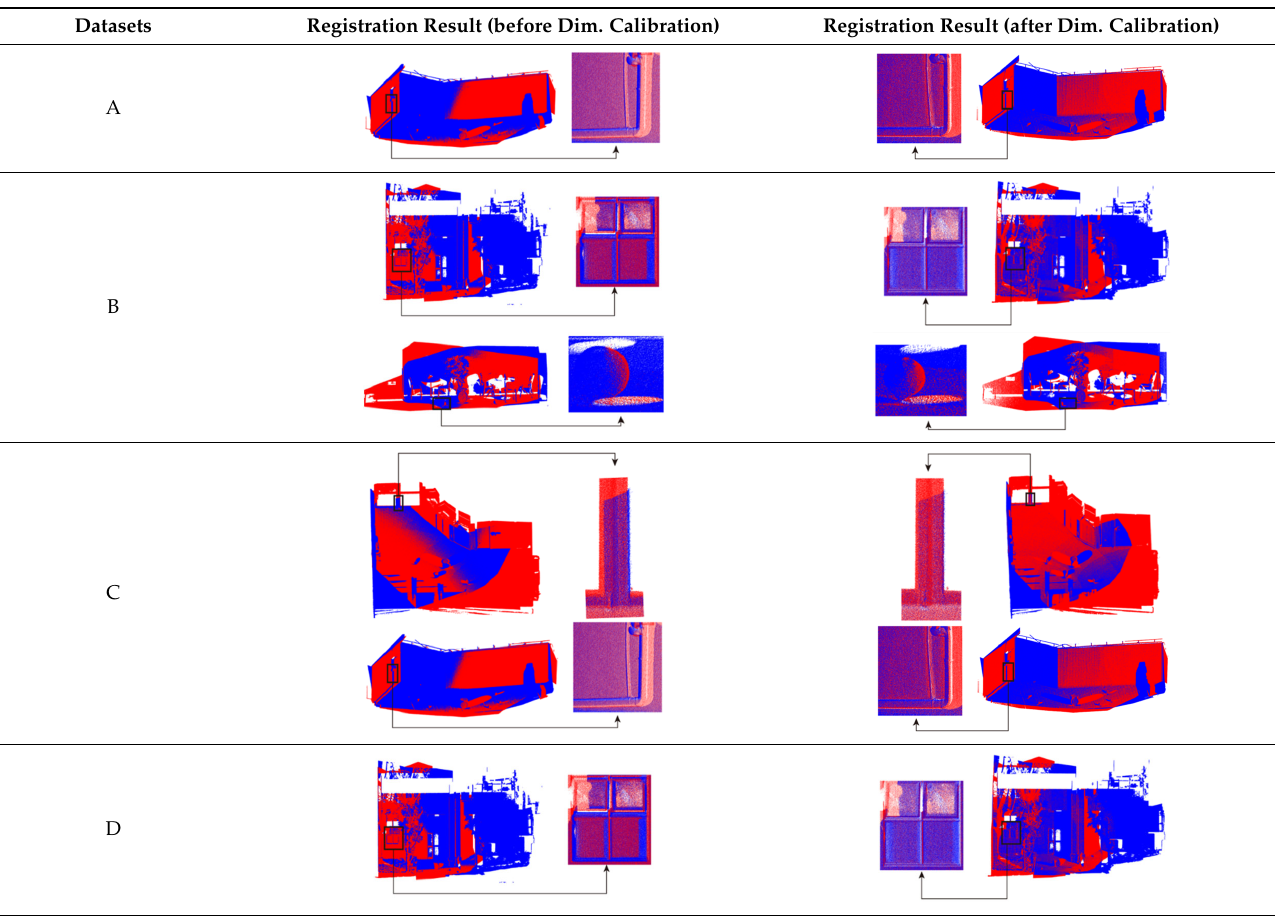
Table 7. Registered point clouds before and after the dimension calibration.